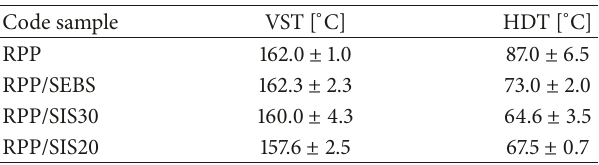
Table 9: VST and HDT properties for the unmodified RPP and RPP